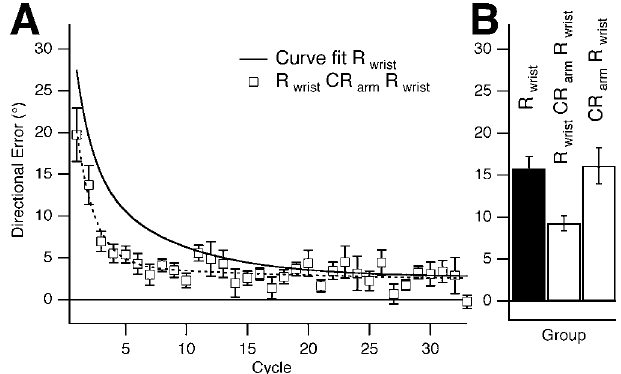
Figure 3. Rotation Learning at the Wrist Is Not Interfered With by Counter-Rotation Learning at the Arm (A) R wrist on day 2, after R wrist followed by CR arm 5 min later on day 1 (group 7, white squares, dashed curve). There was savings from R wrist on day 1 to R wrist on day 2 despite CR arm . The thick black curve represents R wrist on day 1 (group 1). (B) Bar graph showing a statistically significant difference in the reduction in mean directional error in the first six cycles for R wrist on day 1 versus day 2 (groups 1 and 7, mean difference ¼ 6.49 8 , p ¼ 0.0036). This difference was absent when only CR arm was learned on day 1, with no statistically significant difference in the reduction in mean directional error in the first six cycles for day 1 versus day 2 (groups 1 and 8, mean difference ¼ 0.328 8 , p ¼ 0.88). DOI: 10.1371/journal.pbio.0040316.g003 PLoS Biology |